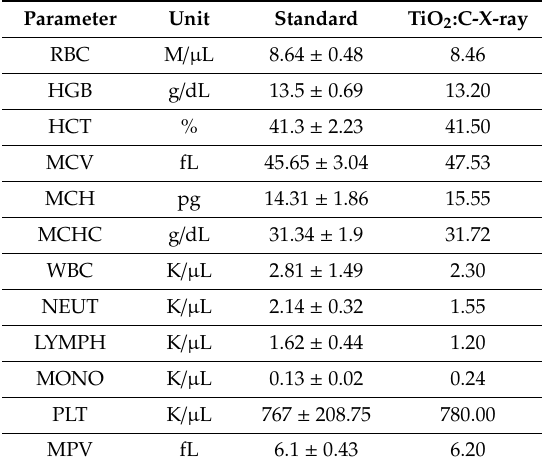
Table 2. Bio-chemical analysis of blood samples from the TiO 2 :C-X-ray group.